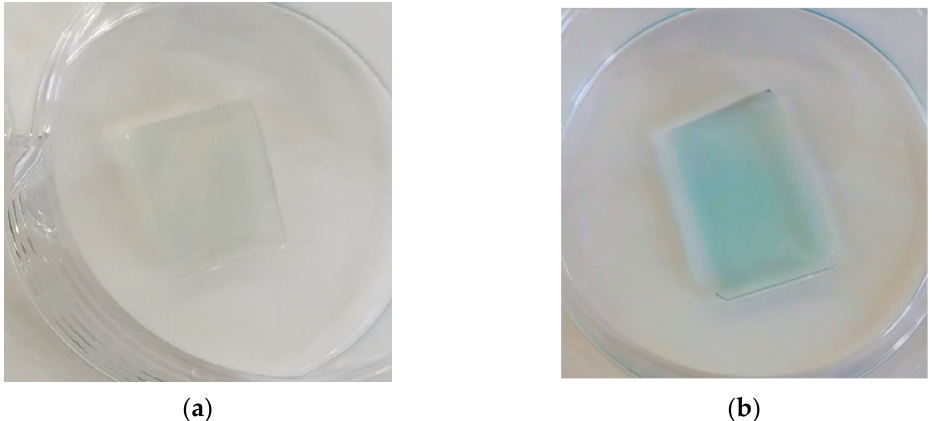
Figure 10. Detection of binding of horseradish peroxidase-conjugated antibodies to the surface of ZnO-coated glasses with bound protein A using TMB treatment: ( a ) glass with ZnO nanorods without MBS treatment, only silanized: negative control; ( b ) glass coated with zinc oxide nanorods silanized with MBS treatment.